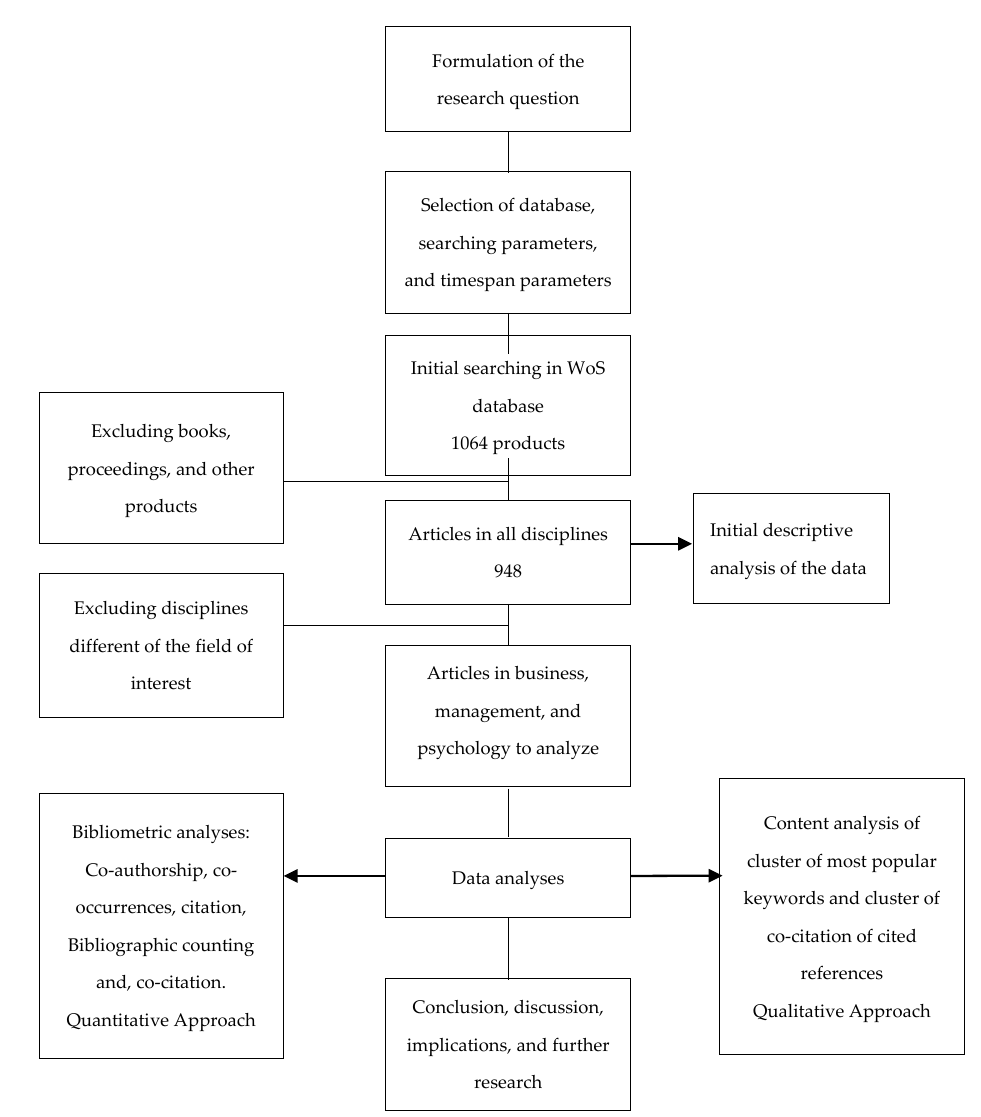
Figure 1. Stages of the research process, following the bibliometric mapping research methodology. The arrows are related to the findings. Source: Authors’ elaboration.